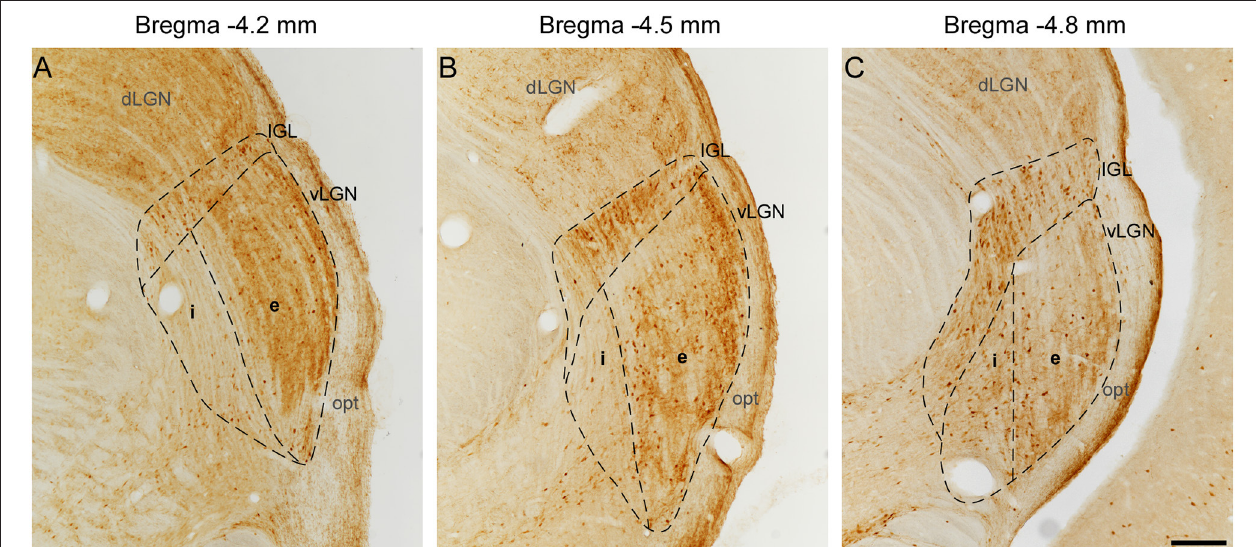
FIGURE 1 | Delineation of IGL, vLGNe, and vLGNe in CR immunolabeled sections at distinct rostrocaudal positions. Distance caudal (–) to Bregma 0.0 (in mm) are indicated at the top of each panel. In the rat lateral geniculate body, dLGN, IGL, and vLGN are bordered laterally by the opt. (A) At − 4.2mm, vLGNi weak background aids in the delineation of its boundary with vLGNe. (B,C) At − 4.5 and − 4.8mm, the medial portion of IGL projects ventrally and stronger immunoreactivity in CR cell bodies denoting the vLGNe/vLGNi border. Scale bar = 200 µ